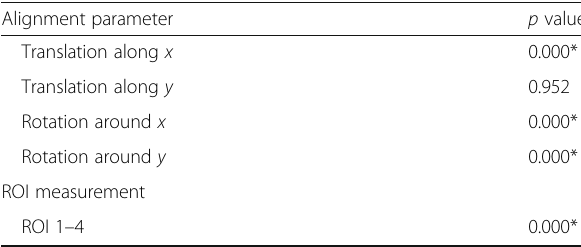
Table 1 Reported p values from the one-sample Student t test, comparing determined parameters and measured mean CT numbers to ground